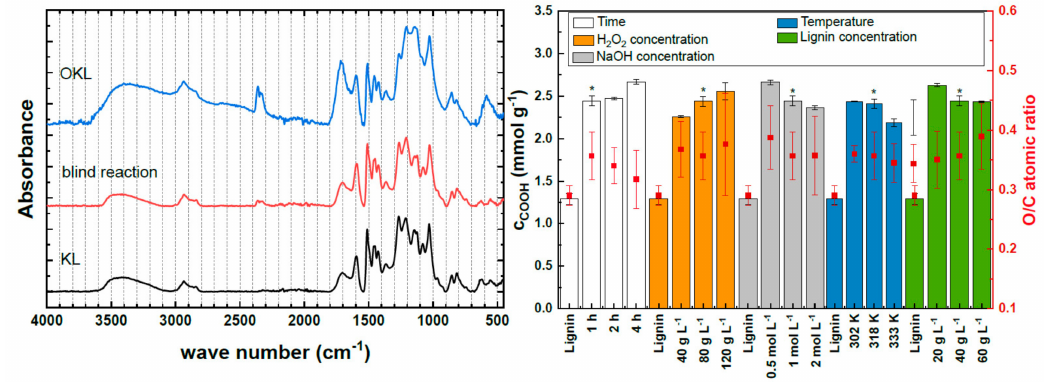
Figure 1. Attenuated total reflection infrared spectroscopy (ATR-IR) spectra of kraft lignin (KL), of lignin after the blind reaction, which was carried out in the absence of H 2 O 2 and of oxidized Kraft lignin (OKL) ( left ), as well as carboxyl group content (c COOH ) and O / C atomic ratio of KL and OKL in dependence of reaction parameters ( right ). The reference reaction is marked by an asterisk (reaction conditions: c lignin = 40 g L − 1 , c H2O2 = 80 g L − 1 , c NaOH = 1 mol L − 1 , T = 318 K, t = 1